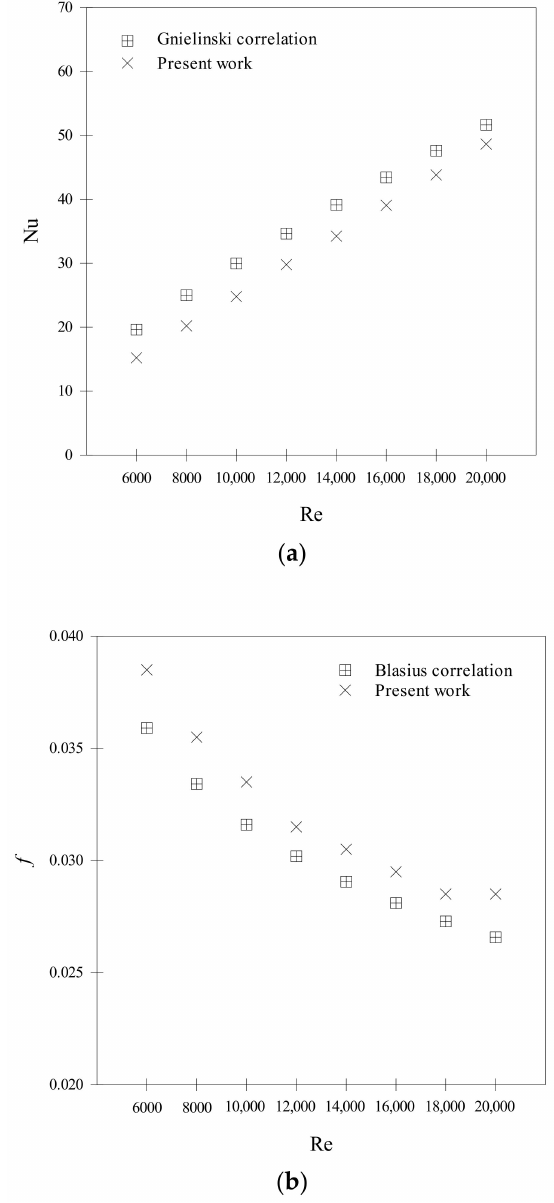
Figure 4. Test for validating a plain tube. ( a ) Nu , ( b ) f